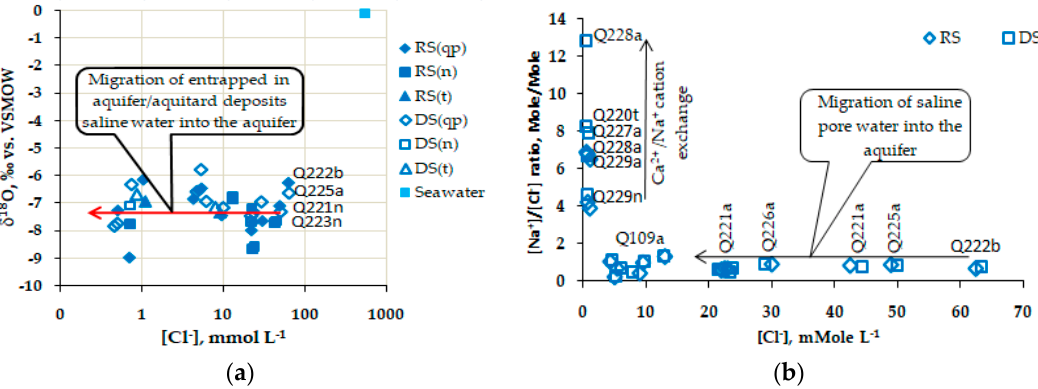
Figure 8. Relationships of δ 18 O vs. molar [Cl − ] ( a ) and molar [Na + ] to [Cl − ] ratios vs. [Cl − ( b ) for groundwater in Pleistocene and Neogene aquifers within the study region showing the migration of entrapped in aquifer and/or aquitard deposits saline pore water to the recharge-fresh water ( a ) as well as the Ca 2+ /Na + cation exchange that proceeds in the areas around the Q227a, Q228a and Q229a boreholes ( b ). ( a ) was drawn in semi-logarithmic scale (see Figure 3 for the boreholes locations).